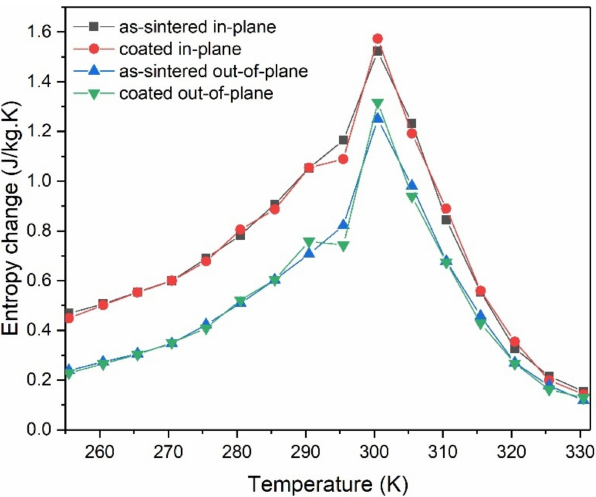
Figure 8. Temperature dependence of magnetic entropy change of as-sintered Ni 50 Mn 33 In 16 Cr 1 alloy and 2 h CoFe-coated Ni 50 Mn 33 In 16 Cr 1 /Cu under a magnetic field of 10